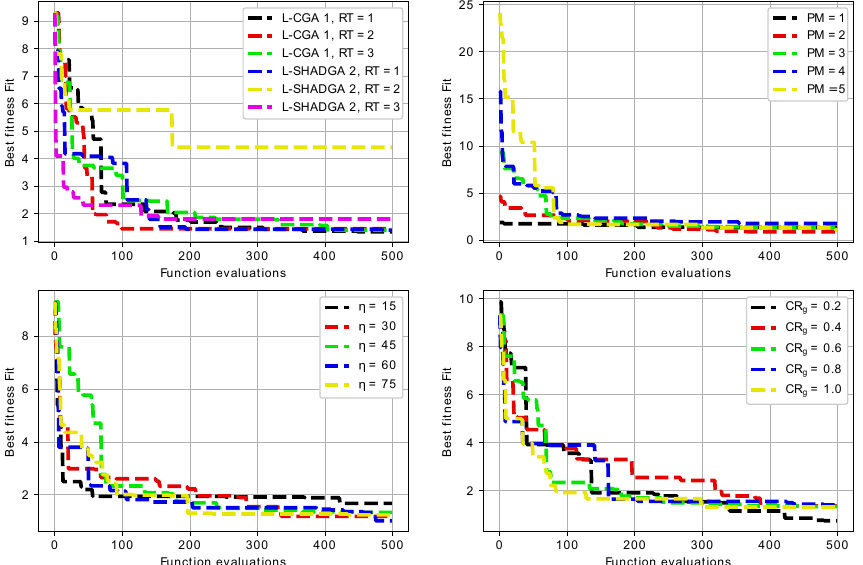
Figure 10. Convergence graphs of algorithms with different parameters for 5-mode